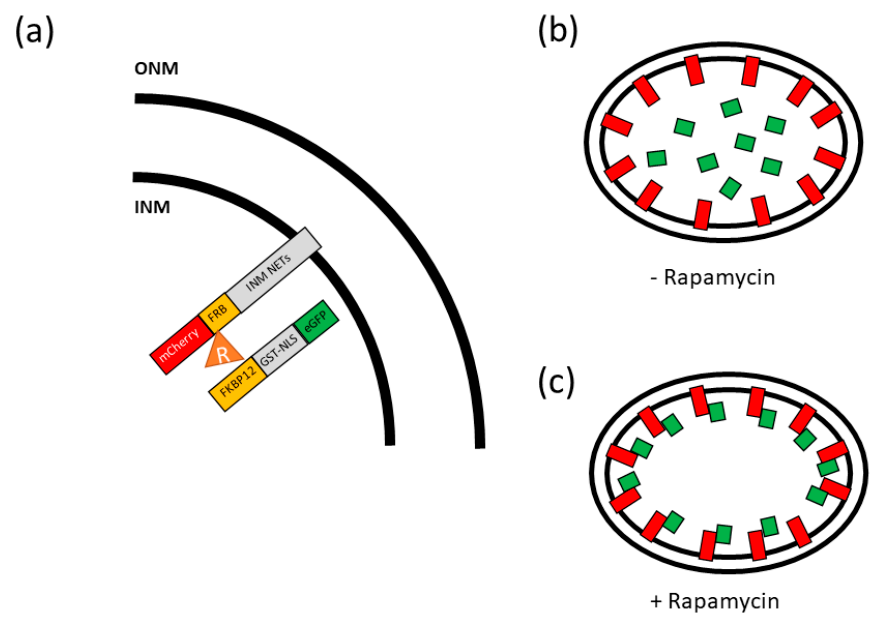
Figure 1. A rapamycin trap for evaluating the presence of nuclear envelope transmembrane proteins (NETs) on the INM: ( a ) A membrane bound NETs tagged with a fluorophore and FRB will dimerize with another fluorescently tagged protein with an 12 kDa FK506 binding protein (FKBP12) domain in the presence of rapamycin, represented here as a triangle. ( b ) In the absence of rapamycin, the soluble Green Fluorescent Protein (GFP) labeled protein (green blocks) will not dimerize with the membrane bound NETs (red blocks) and diffuse throughout the nucleus. ( c ) In the presence of rapamycin the soluble GFP labeled protein (green blocks) will dimerize with the membrane bound NETs (red blocks) and localize to the nuclear envelope.